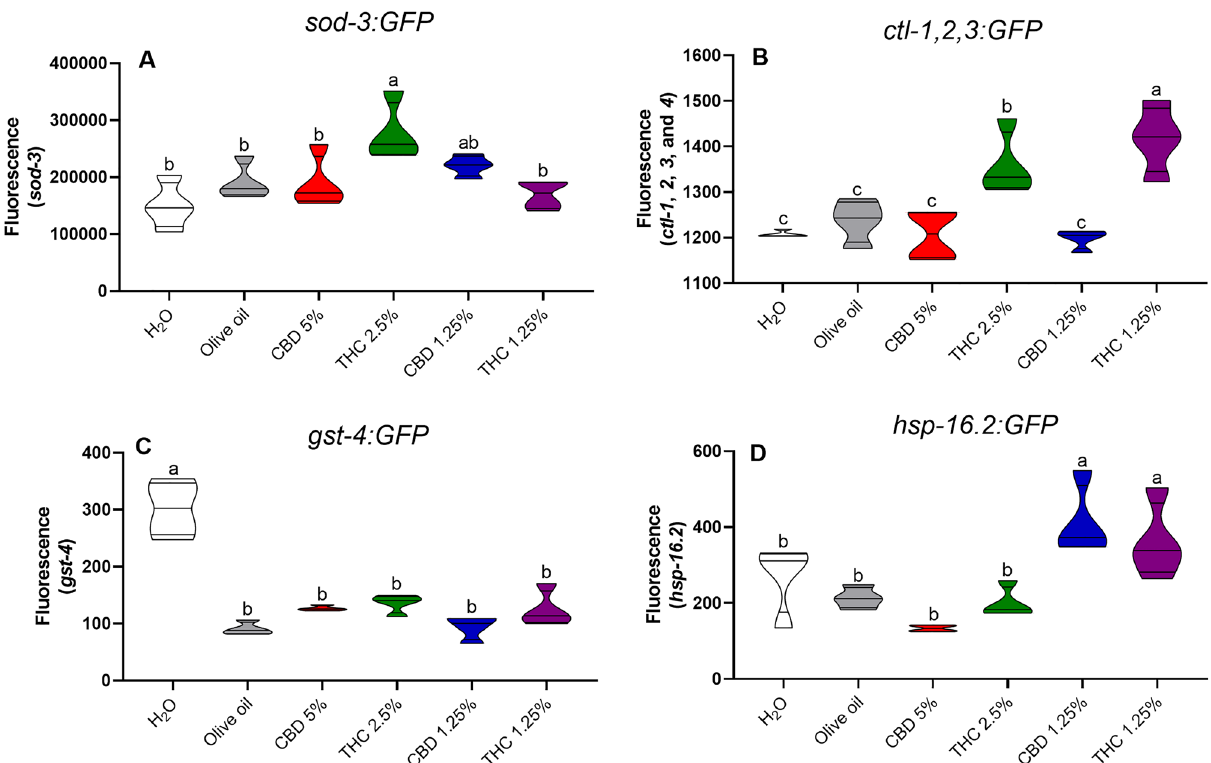
Figure 4. Antioxidant enzymes expression by green fluorescent protein (GFP) in C. elegans Sod-3:GFP mutant strain expressing superoxide dismutase ( A ), Cat-1,2,3:GFP mutant strain expressing catalase ( B ), Gst-4:GFP mutant strain expressing glutathione-S-transferase ( C ), and Hsp-16.2:GFP mutant strain expressing heat shock protein ( D ). Data are expressed by the mean ± standard error (SEM). Means followed by the same letter are not significantly different according to Tukey’s test ( p >